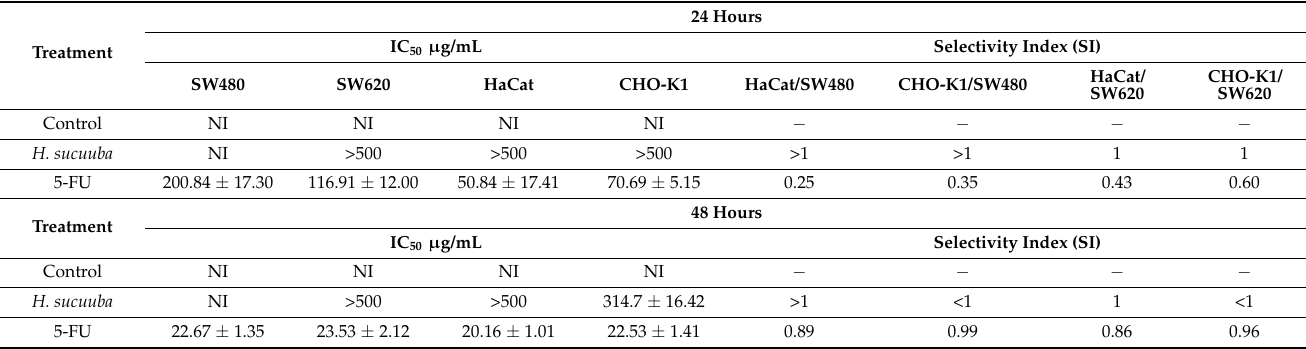
Table 2. Cytotoxic activity of H. sucuuba latex on colon cancer cell